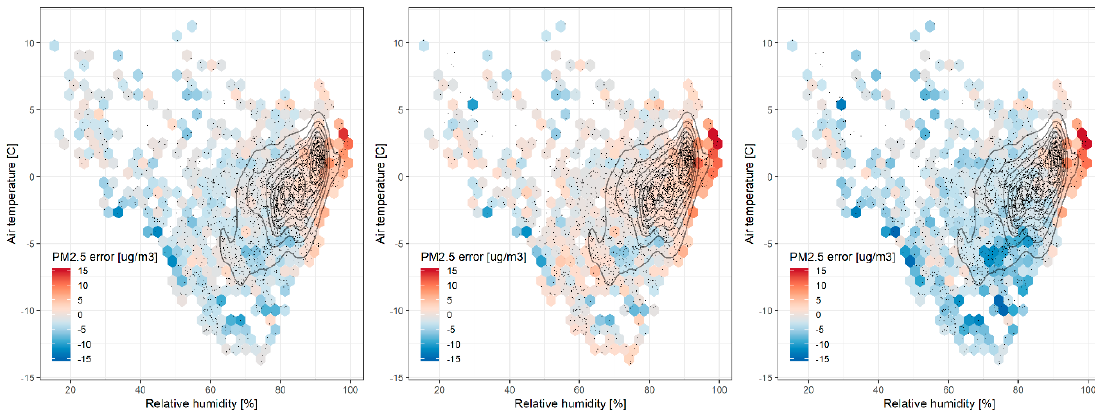
Figure 9. Observed PM 2.5 sensor error (measured as sensor observation minus reference data) as a function of both relative humidity and air temperature. Small black dots represent the actual observations. The coloured hexagons indicate the mean PM 2.5 sensor error of all the observations falling in each hexagon. The isolines represent the density of data points, highlighting where the majority of observations are located.